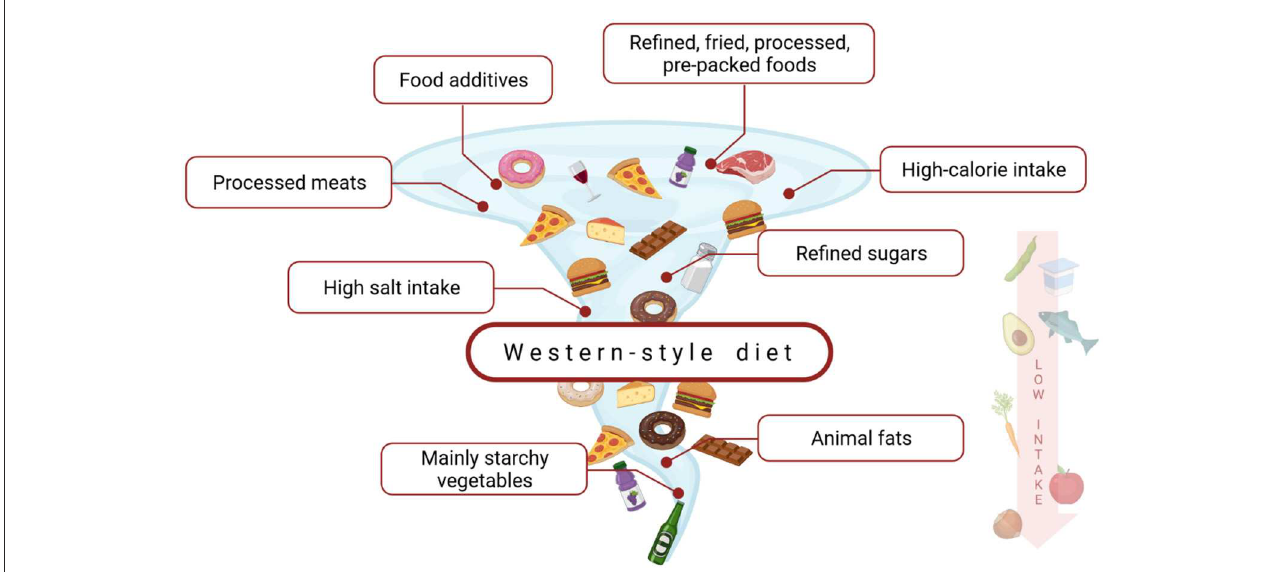
FIGURE2 The characterization of a western-style diet. This dietary model is a high-caloric diet, rich in saturated fats, refined carbohydrates, animal protein, salt, and food additives. At the same time, it is low in fiber, vitamins, and minerals (102,